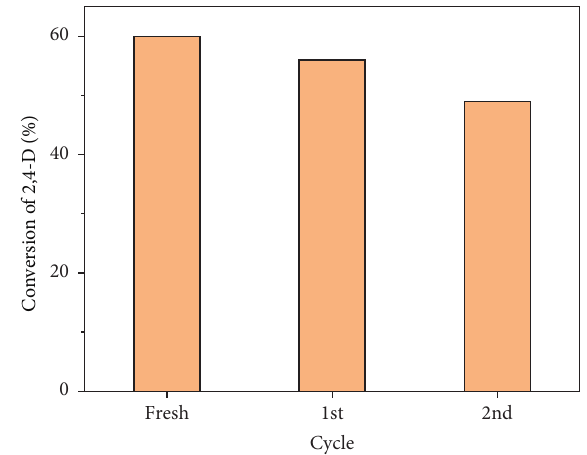
Figure 12: The recycle test of 2,4-D solution photodegradation over 2.5Ti-SBA-15/C 3 N 4 under visible light